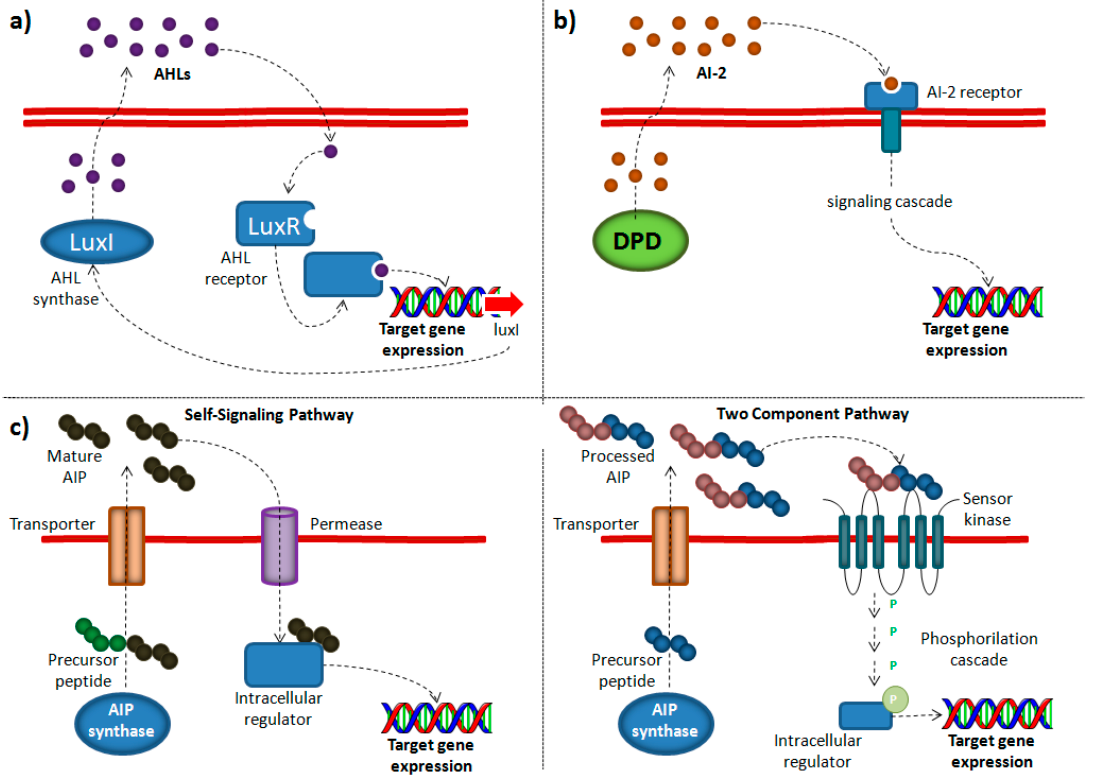
Figure 1. Simplified QS circuit diagrams of ( a ) AI-1, ( b ) AI-2 and ( c ) AIP (“Self-Signaling” and “Two Component” pathways) mechanisms.